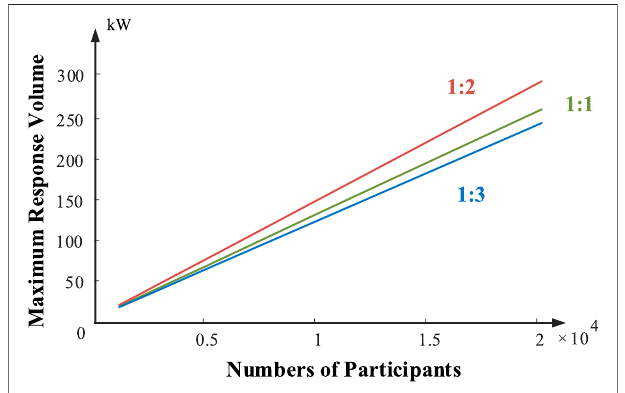
FIGURE 11 | Maximum response volume of different numbers of users with different type ratios.